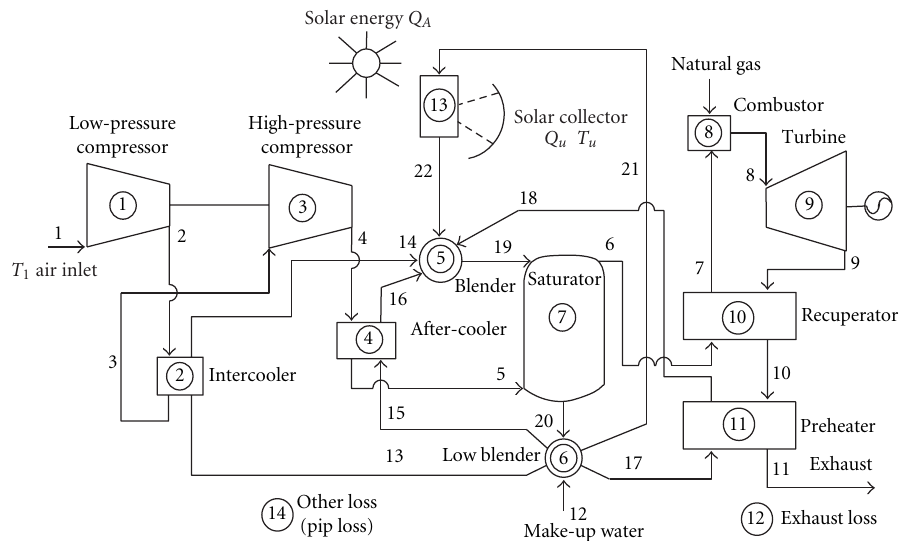
Figure 1: The flow diagram of the HAT cycle with low- or medium-temperature solar